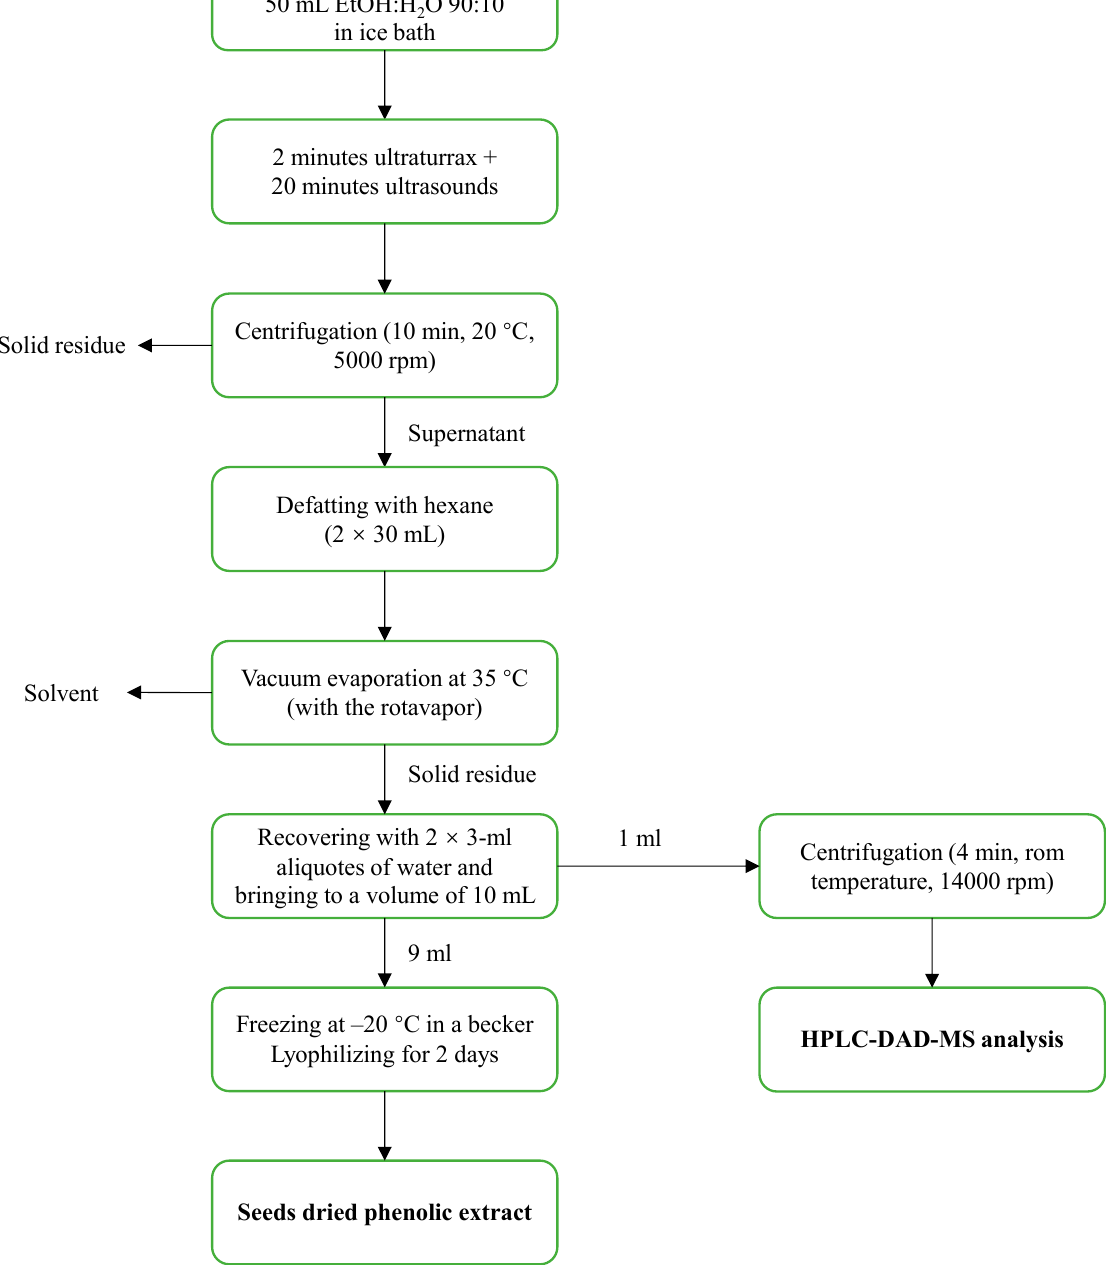
Figure 1. Procedure for the preparation of dry phenolic extracts from seeds.